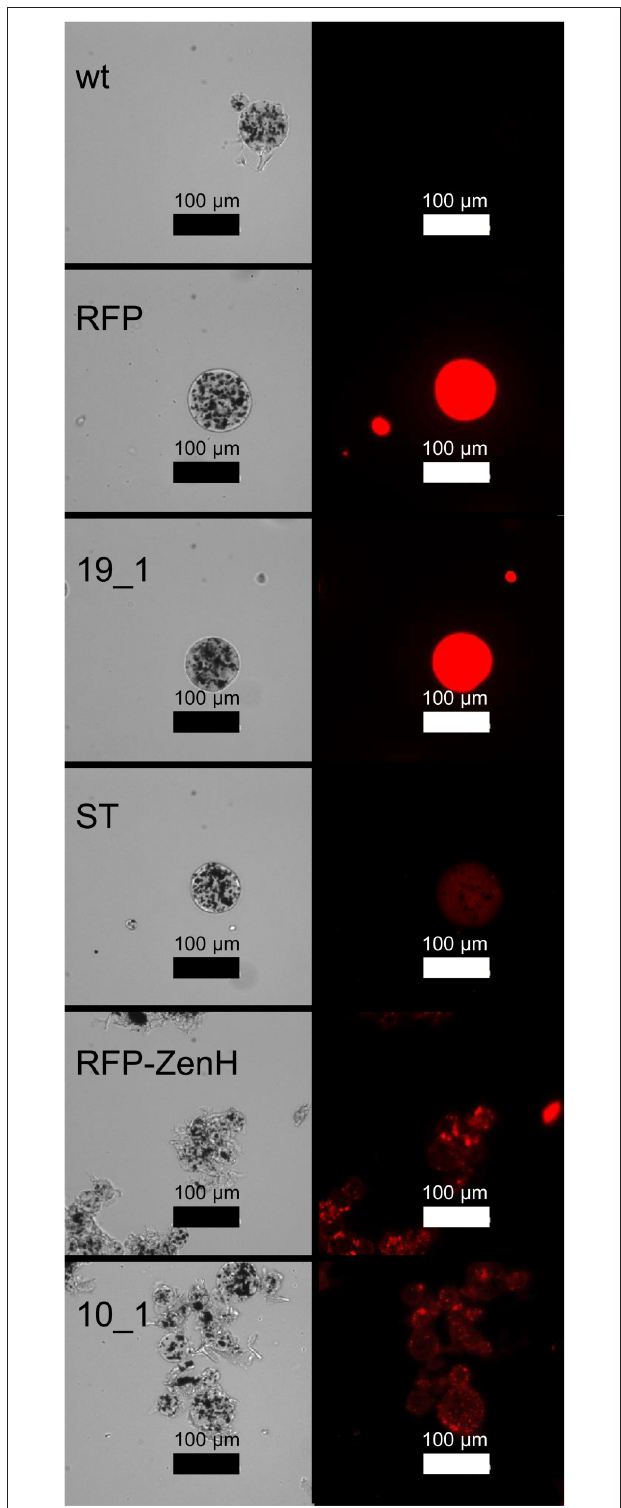
FIGURE 4 | Visualization of insoluble aggregate formation. Analysis of selected RFP-fusion proteins after purification from plant crude extracts